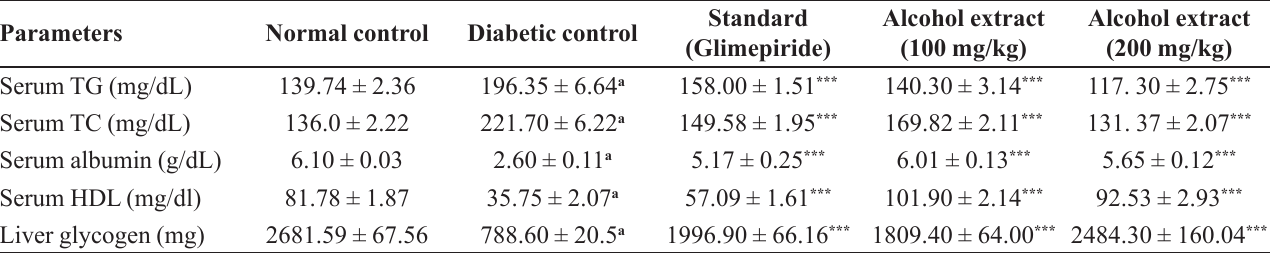
TABLE II - Effect of alcohol extract of W. volubilis root on serum parameters in Wistar rats Parameters